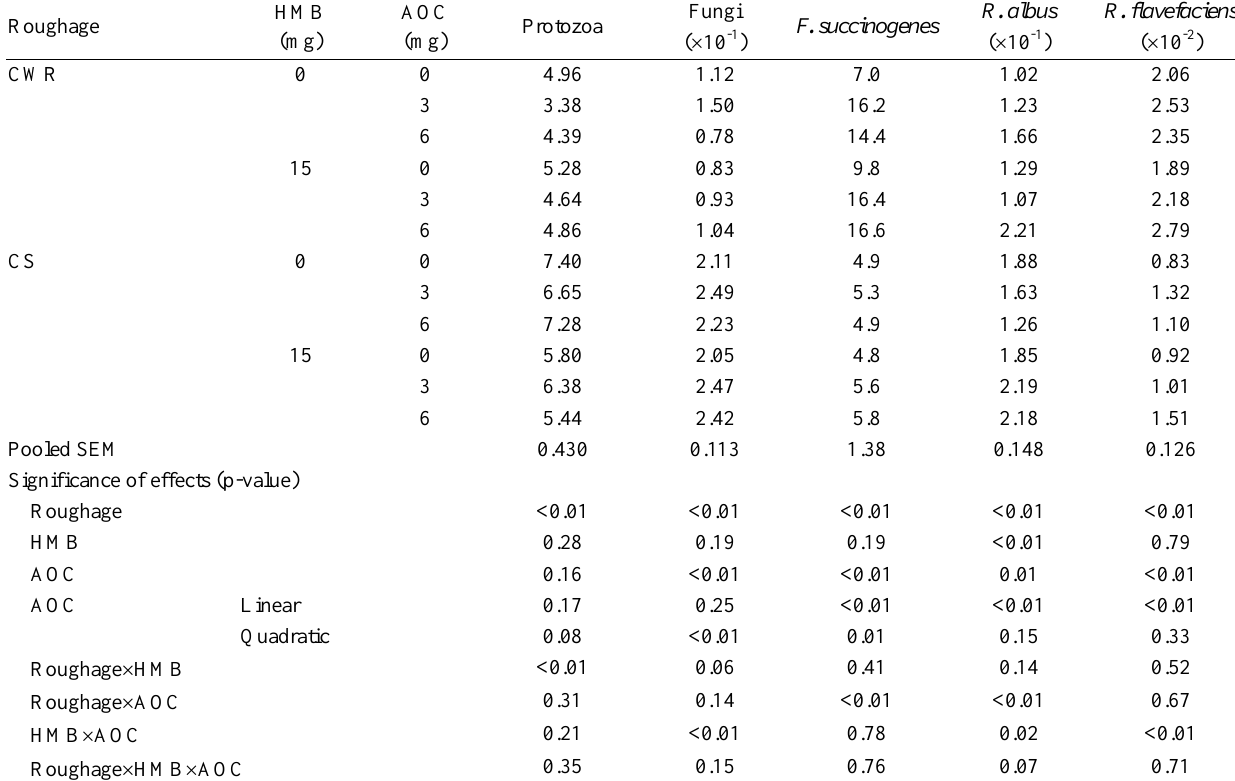
Table 6. Effects of AOC and HMB on microbial populations (% of total bacterial 16S rDNA) for different roughage sources